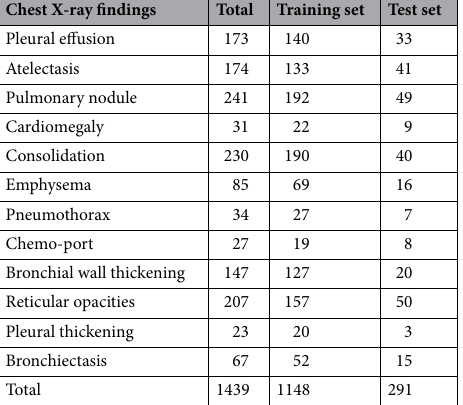
Table 1. Summary of one-to-one CT matched chest X-ray bounding box data. The expert-labeled data was described. In the training set, approximately 80% of data were included. Its range is various from 20 to 192 bounding